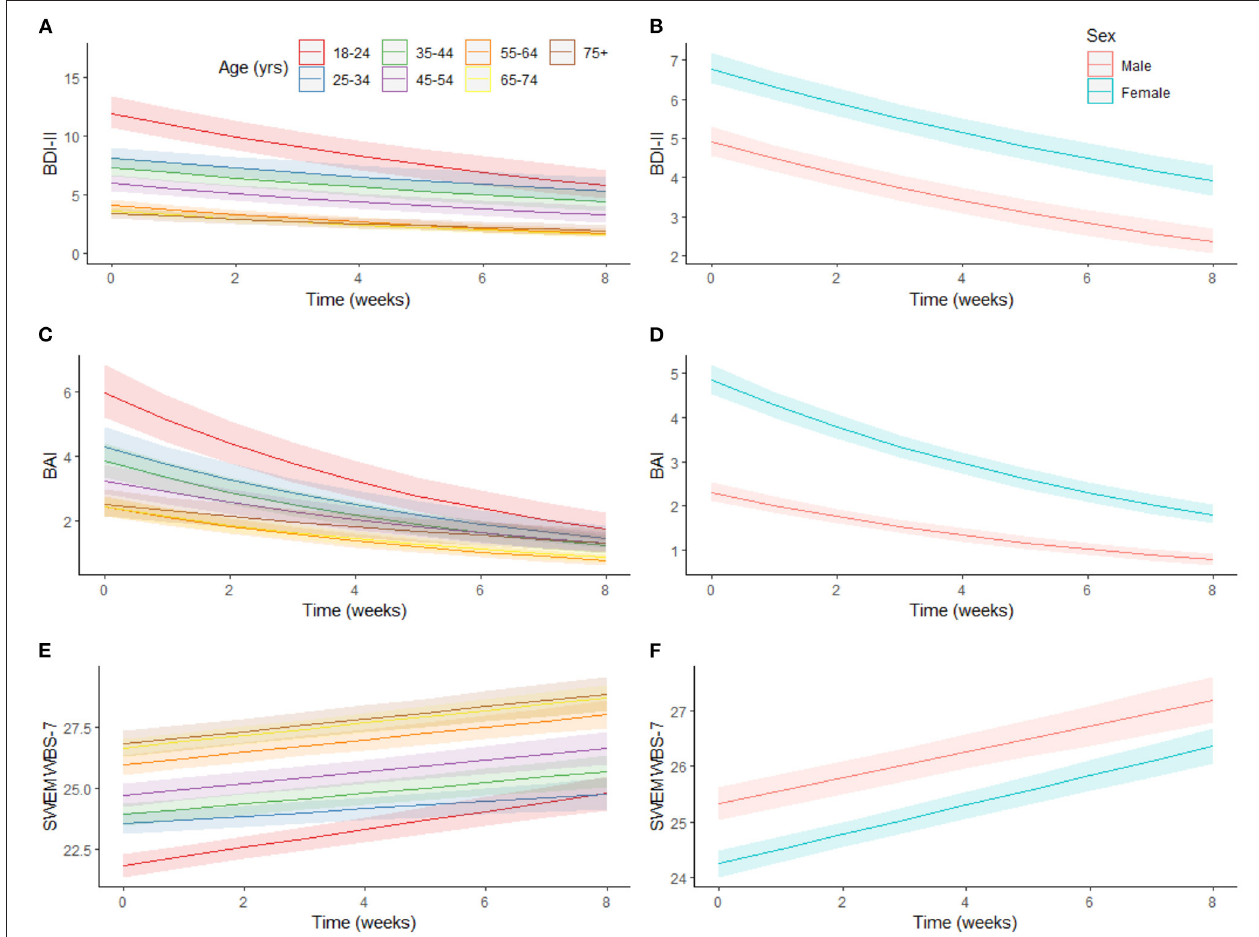
FIGURE 2 | Association between changes in mental health over time by age, and sex. Marginal effects plot showing trajectories in depressive symptoms (A,B) , anxiety symptoms (C,D) and positive mental health (E,F) over time by age and gender, holding covariates at their mean (for continuous variables) or proportions (for factor variables). BAI, Beck Anxiety Inventory, BDI-II, Beck Depression Inventory II, SWEMWBS-7, Short Warwick-Edinburgh Mental Well-being